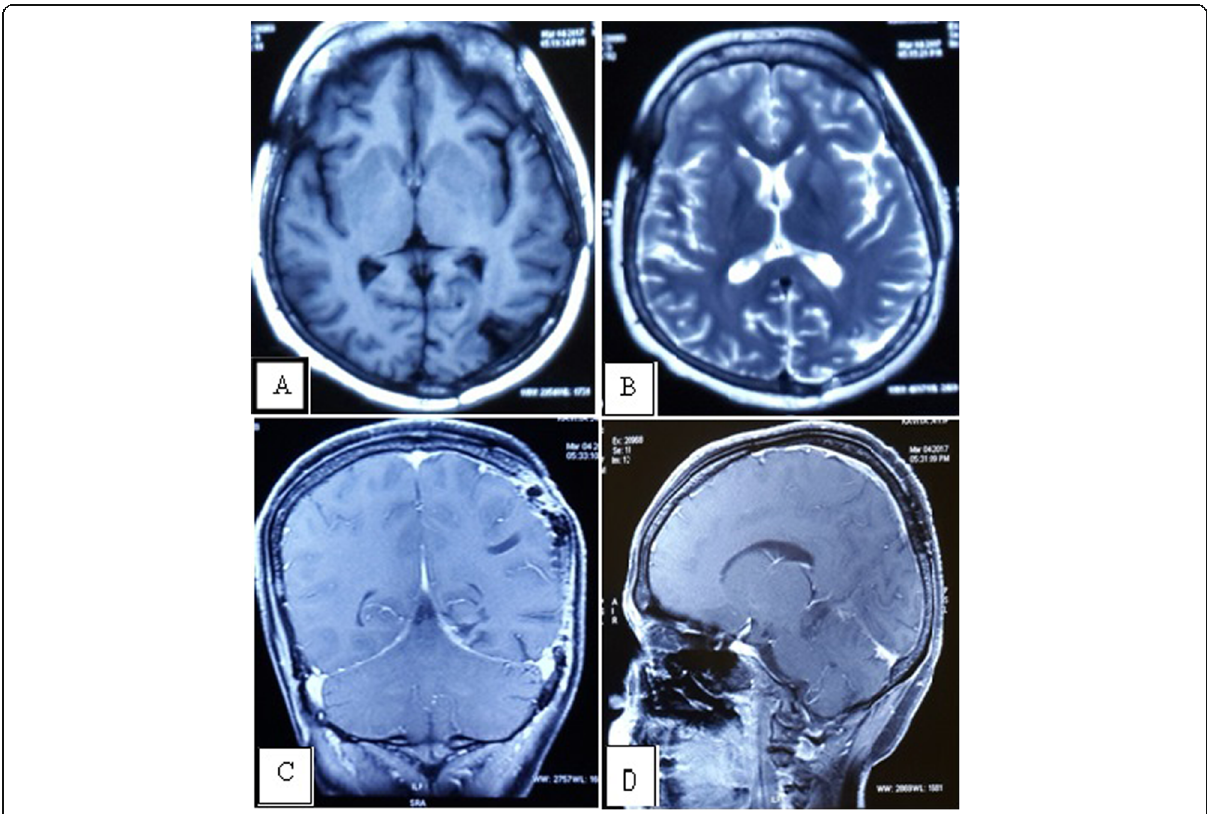
Fig. 4 Post-op CEMRI of the brain shows post-operative changes with no contrast enhancement. T1 and T2 axial ( a , b ) and T1 with contrast coronal and sagittal ( c , d )